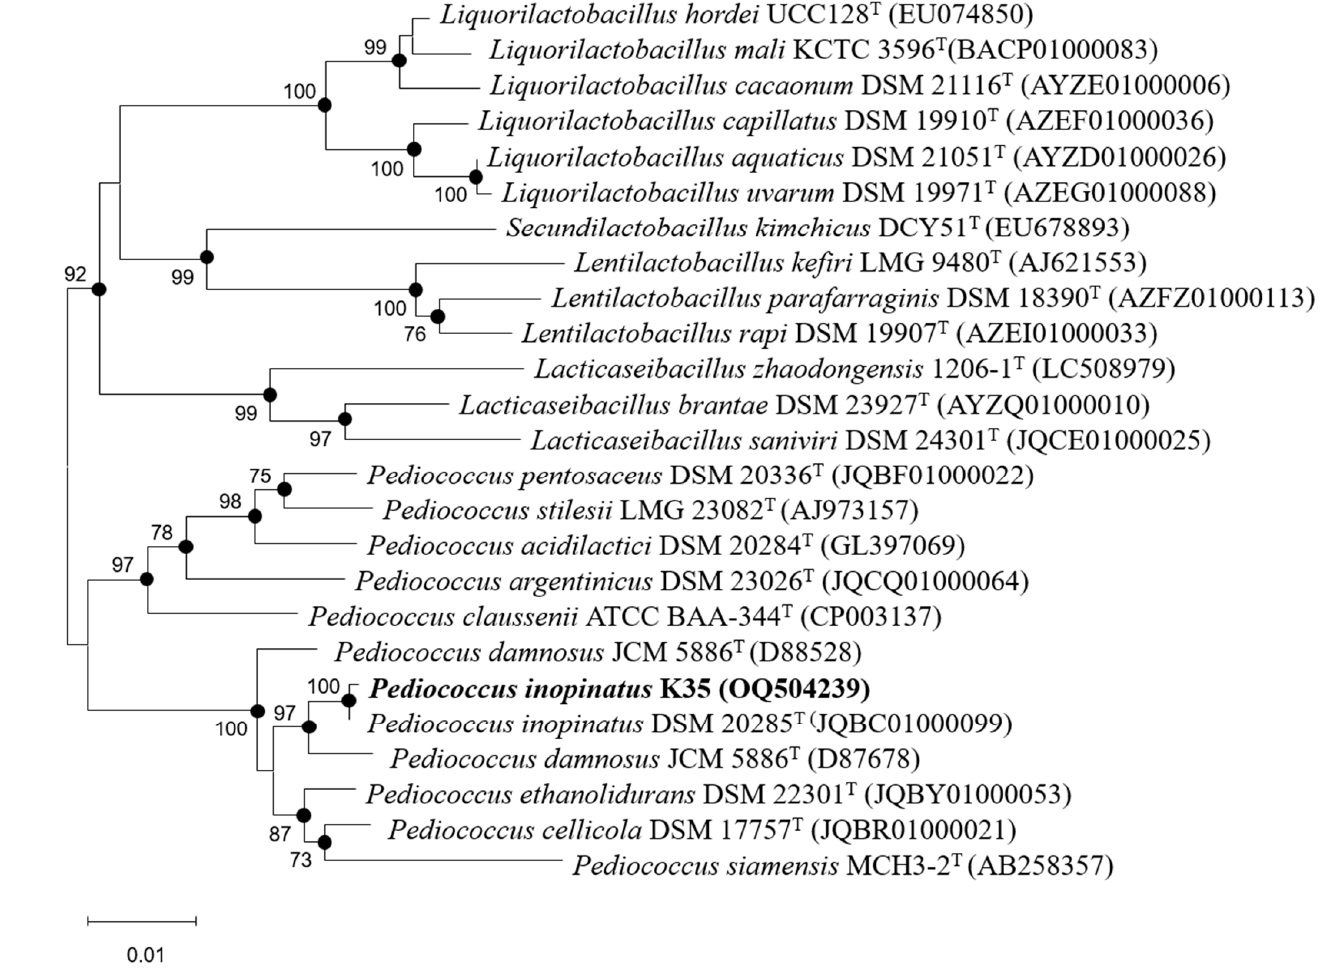
Figure 3. Neighbor-joining phylogenetic tree of strain K35. Bootstrap values (expressed as a percentage of 1000 replications) > 65% are shown at the branch points. Bar, 0.01 substitutions per nucleotide position. Table 4. Biochemical and cultural characteristics of strain K35 and Pediococcus inopinatus DSM 20285 T . +, Positive; − , negative; w, weakly